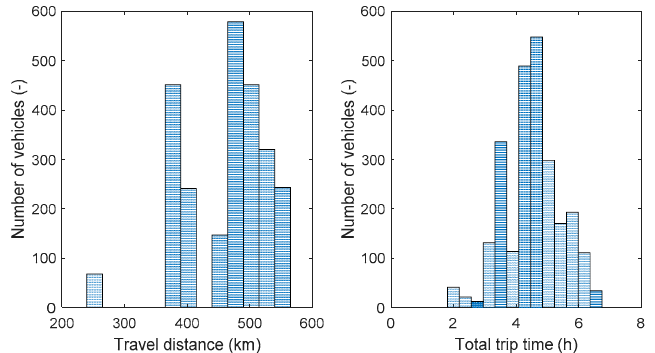
Figure 9. Generated vehicle trip characteristics.